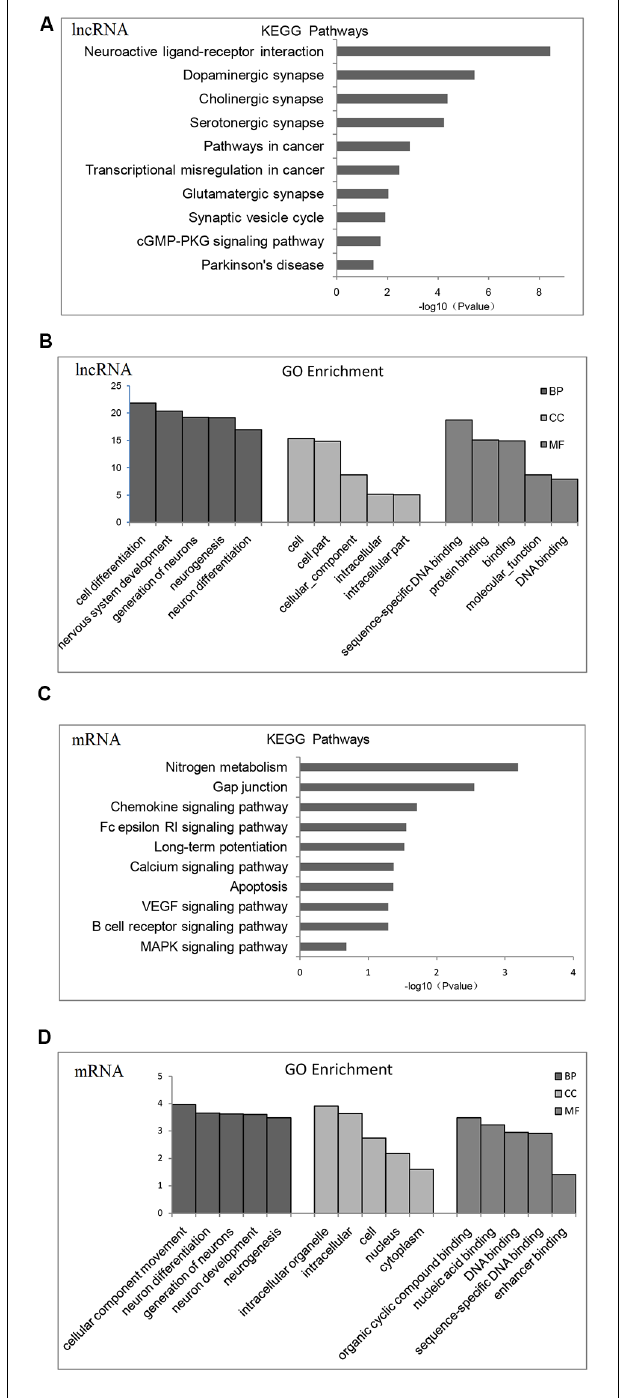
FIGURE 2 | Gene Ontology (GO) functional enrichment and Kyoto Encyclopedia of Gene and Genomes (KEGG) pathways analysis of differentially expressed mRNAs and lncRNAs in the brains of chronic T. gondii infected mice. (A) KEGG pathways analysis for differentially expressed dysregulated lncRNAs target genes. The vertical axis represents the pathway category and the horizontal axis represents the enrichment score [ − log 10 ( p -value)] of the pathway. (B) GO functional enrichment analysis for dysregulated lncRNAs target genes. The top five groups in the three main